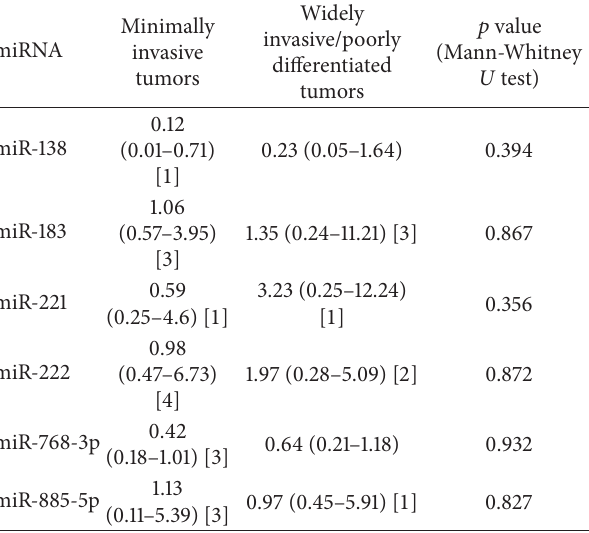
Table 6: Comparison of relative expressions of miRNA between patients with minimally invasive tumors and patients with widely invasive or poorly differentiated